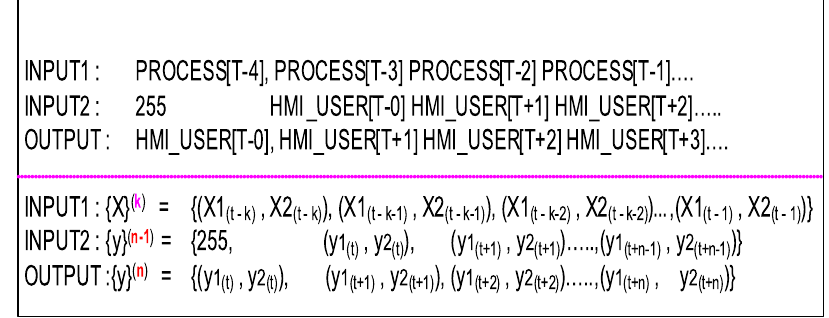
Figure 9. Teacher Forcing—Training Data Stream. INPUT 1 is the encoder training input which